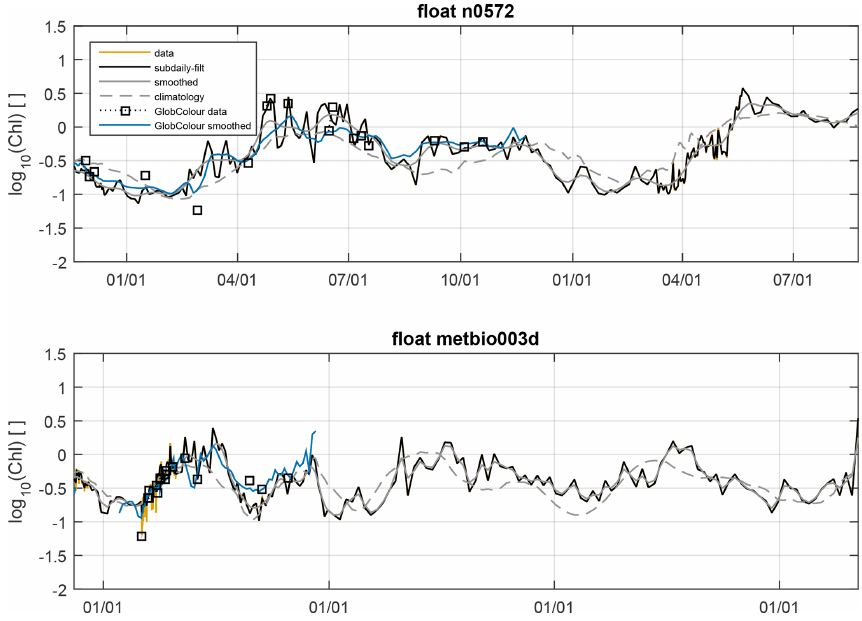
Figure B1. Example time series of log-transformed, depth-reduced Chl from two floats (n0572 and metbio003d). Data are orange, data with sub-daily filter applied are black, the “smoothed” subtrahend is solid grey, and the “climatology” subtrahend is dashed grey. For evaluation, we also display the GlobColour data projected onto the float tracks (black squares) and the Eulerian smoothed subtrahend from GlobColour projected onto the float tracks (solid blue). Note that the sample interval was generally over 1d except for brief intervals so that sub-daily filtered and unfiltered series are generally identical (black curve generally over orange). Note also the variable sample rate for metbio003d, illustrating how the effective cutoff period of the smoothed subtrahend can vary substantially from 31d.